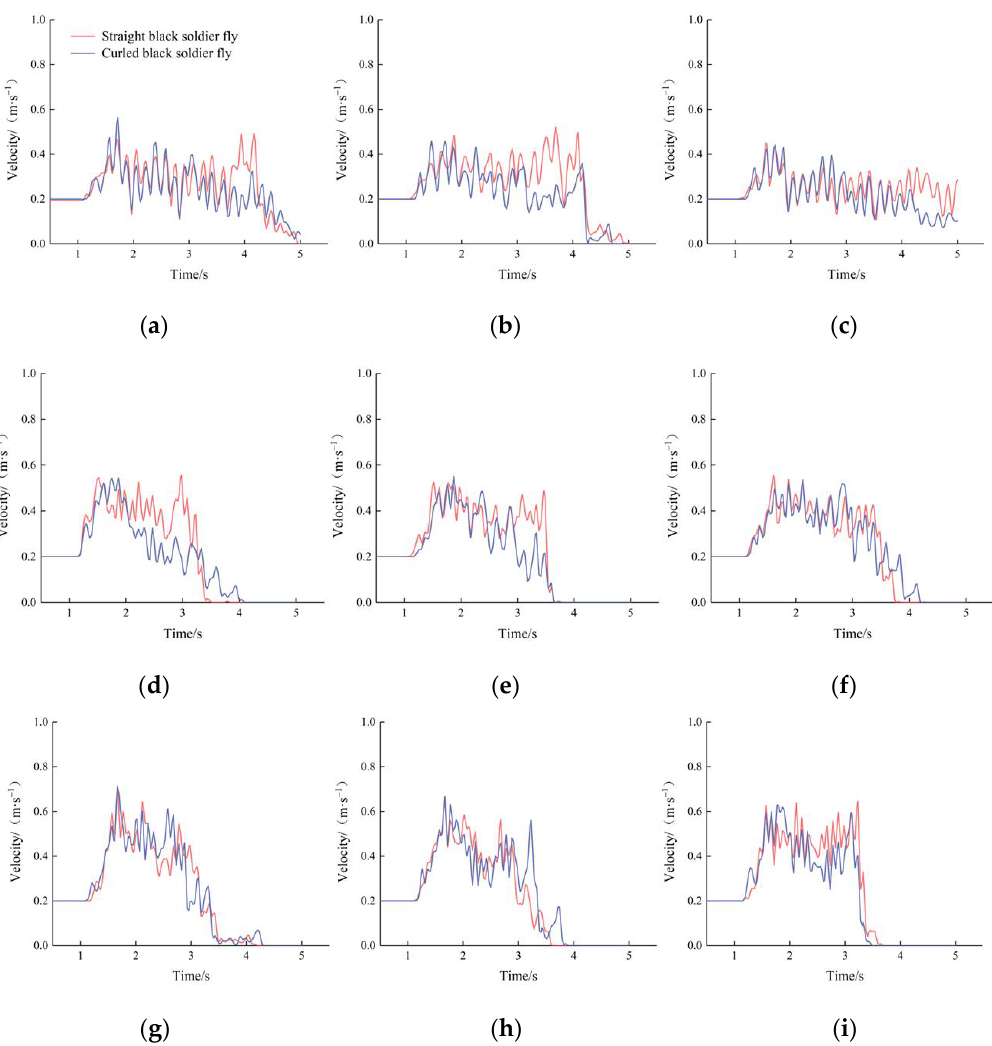
Figure 17. Resultant velocity magnitude analysis in the separation movement of black soldier fly.